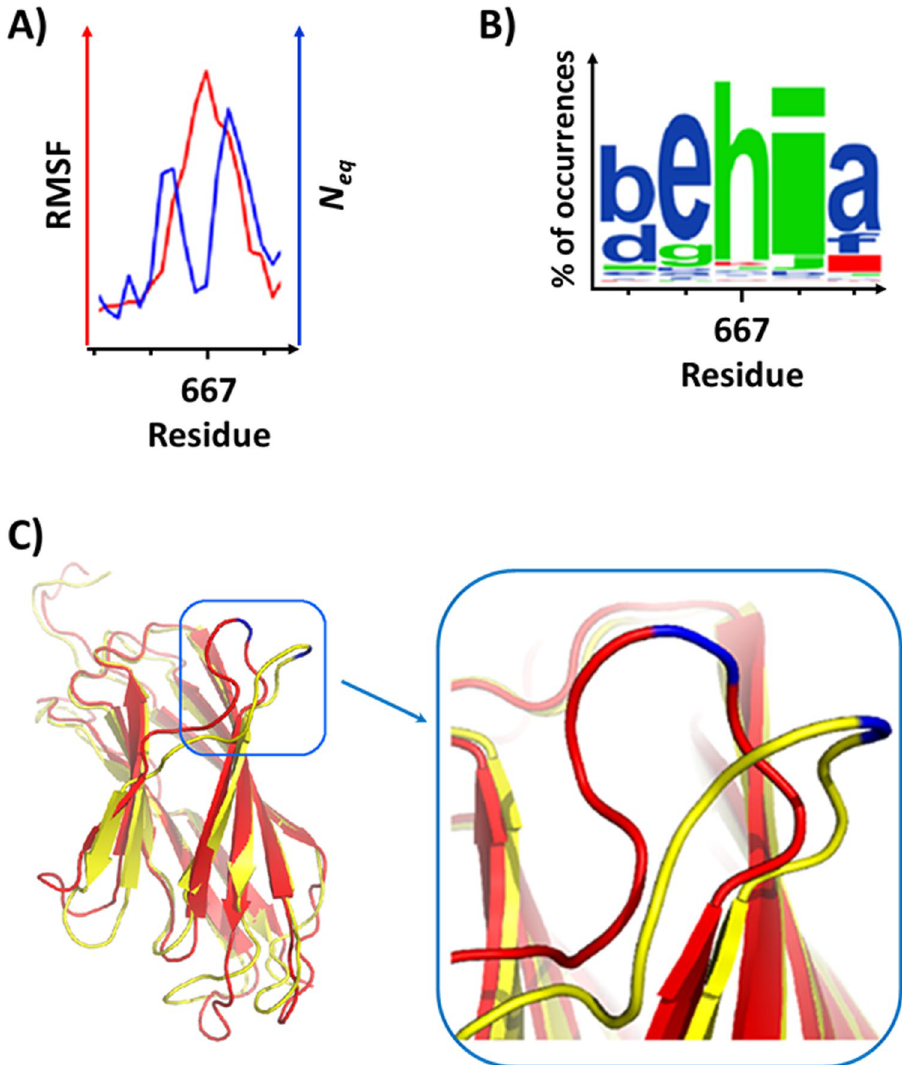
Figure 4. Local rigid conformation in a deformable loop, low N eq versus high RMSF. ( A ) Superimposed RMSF and N eq values (red and blue curves respectively) from residues N665 to G668, ( B ) The WebLogo 49 indicates the frequency of occurrences with respect to the PBs adopted (size of the letter) by a residue in MD simulations. Here, residues V666 to F669 mainly adopted the PBs profile “e hia” corresponding to low N eq for them. ( C ) 3D model of the Calf-1 domain and the frame magnified of two adopted by the loop conformations (red and yellow worm-lines) carrying the residue E667 (in blue) that keep a rigid structure relative to the mobile